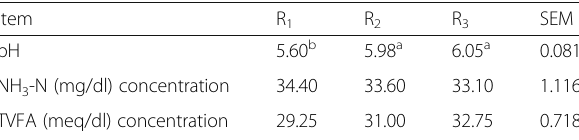
Table 6 Ruminal fluid parameters of the experimental groups